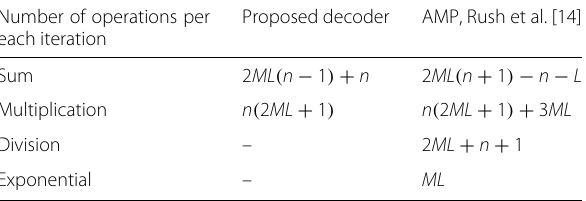
Table 2 Computational complexity comparison Number of operations per each